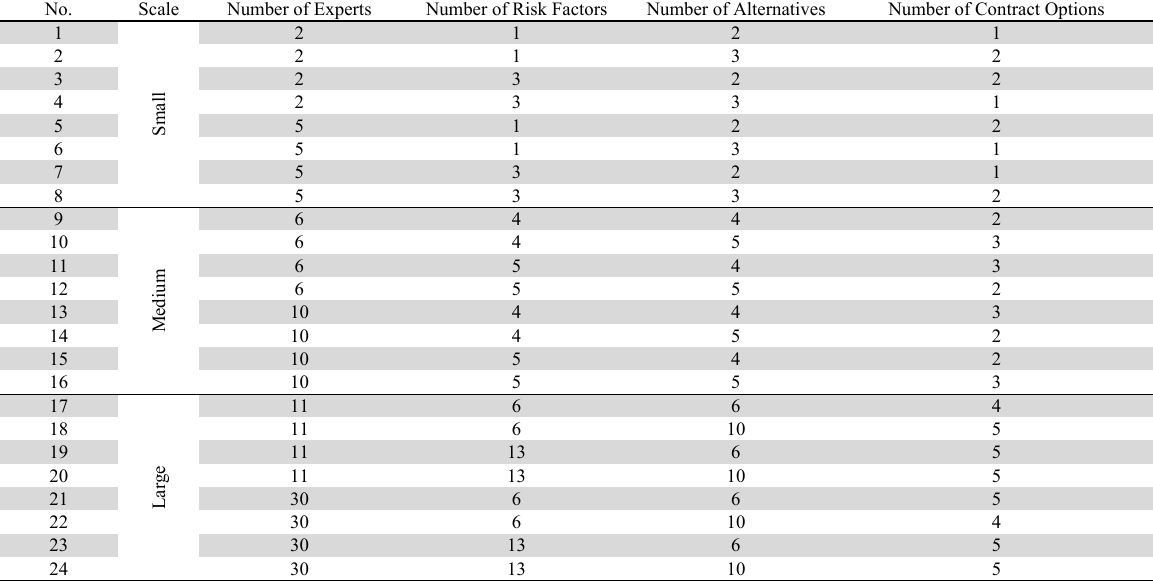
The Designed Case Studies (Taguchi L2^4) No. Scale Number of Risk Factors Number of Alternatives